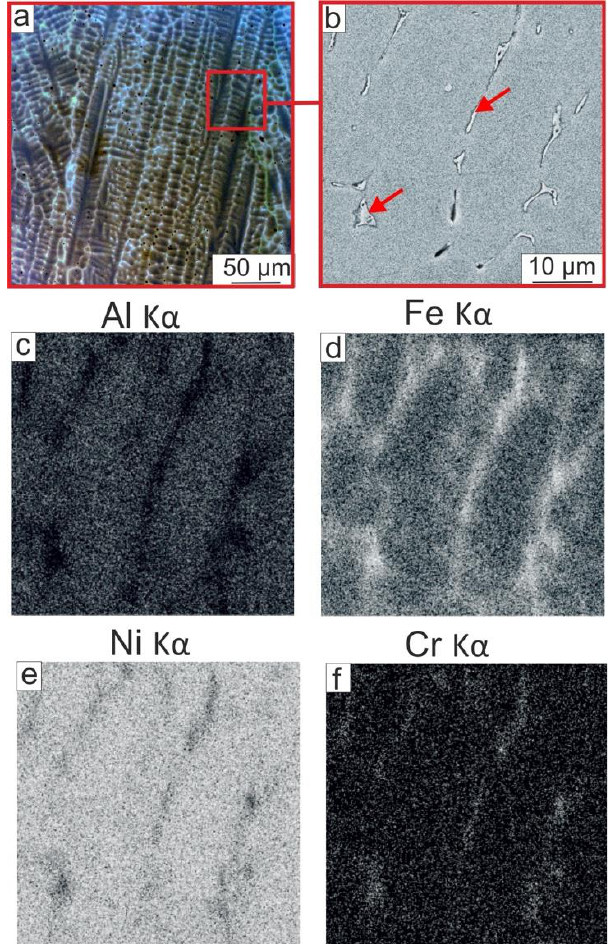
Figure 5. The structure of the NiAl-based coating: ( a ) The dendritic structure of the NiAl-based coating revealed by optical metallography; ( b ) SEM of the coating area marked with a red frame in ( a ); ( c – f ) EDX maps for the area shown in ( b ).